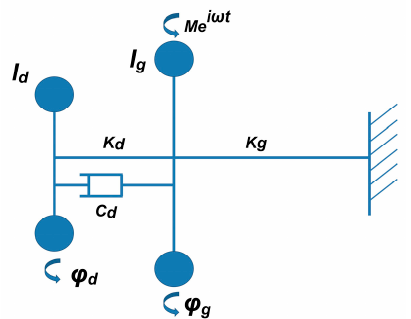
Figure A1. Dual degrees of freedom torsional system.